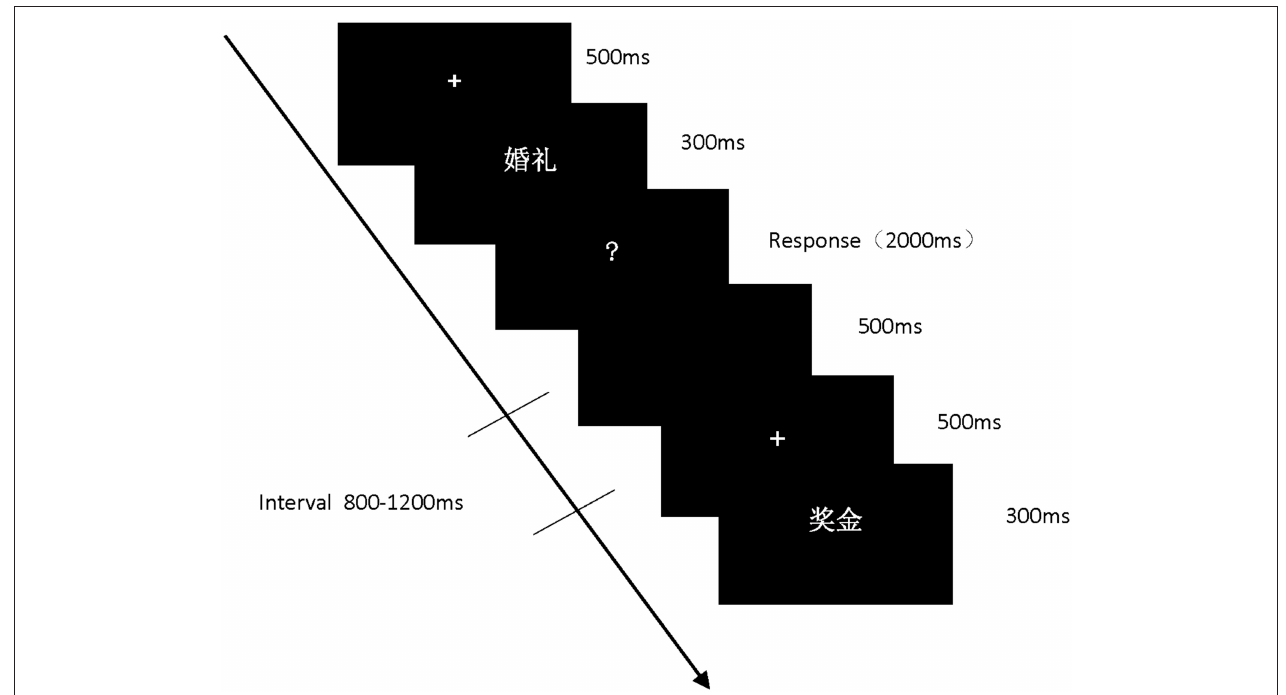
FIGURE 1 | The sequence of